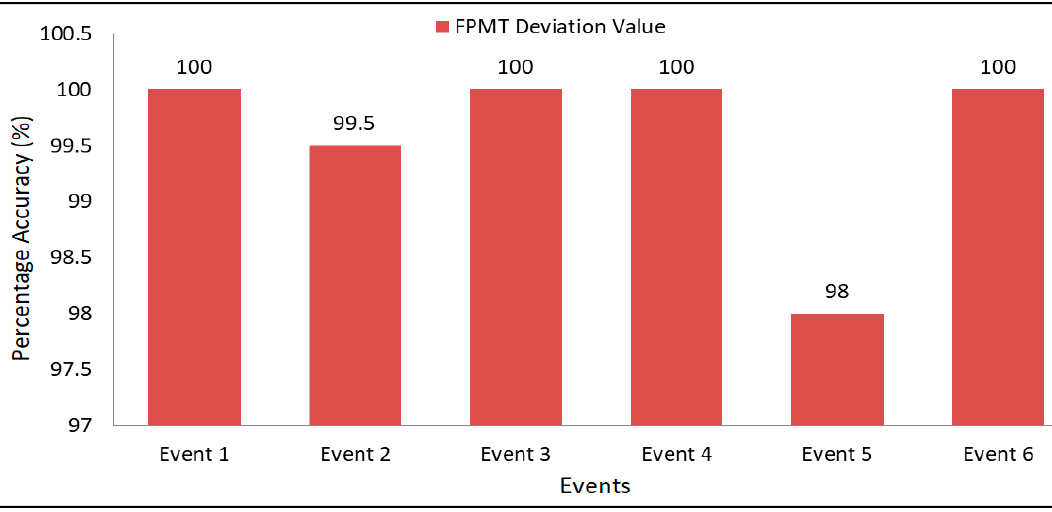
Figure 16. Improved FPMT technique measurement accuracy.